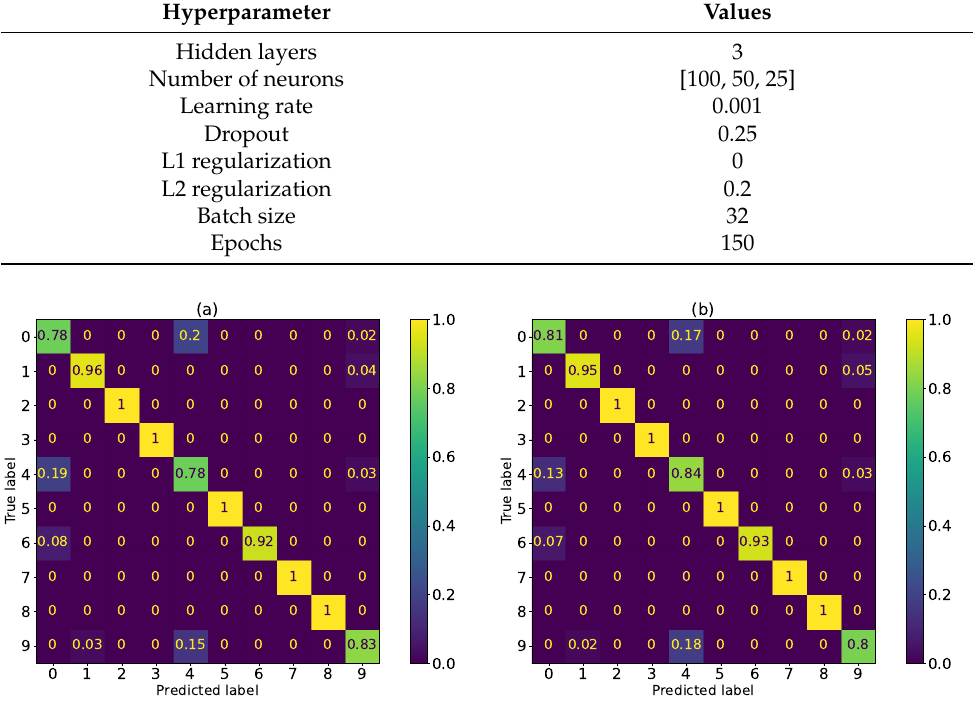
Table 4. Tuned hyperparameters of the neural network with high generalization. Hyperparameter Values Hidden layers 3 Number of neurons [100, 50, 25] Learning rate 0.001 Dropout 0.25 L1 regularization